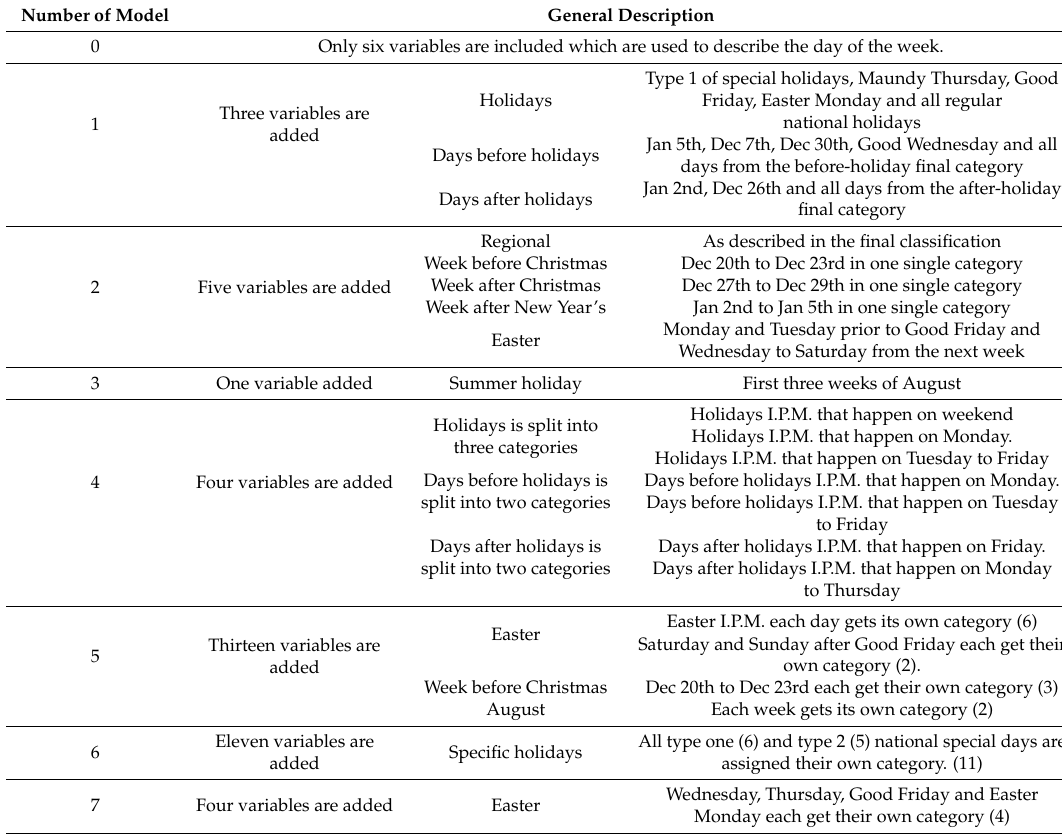
Table 6. Summary of incrementally complex